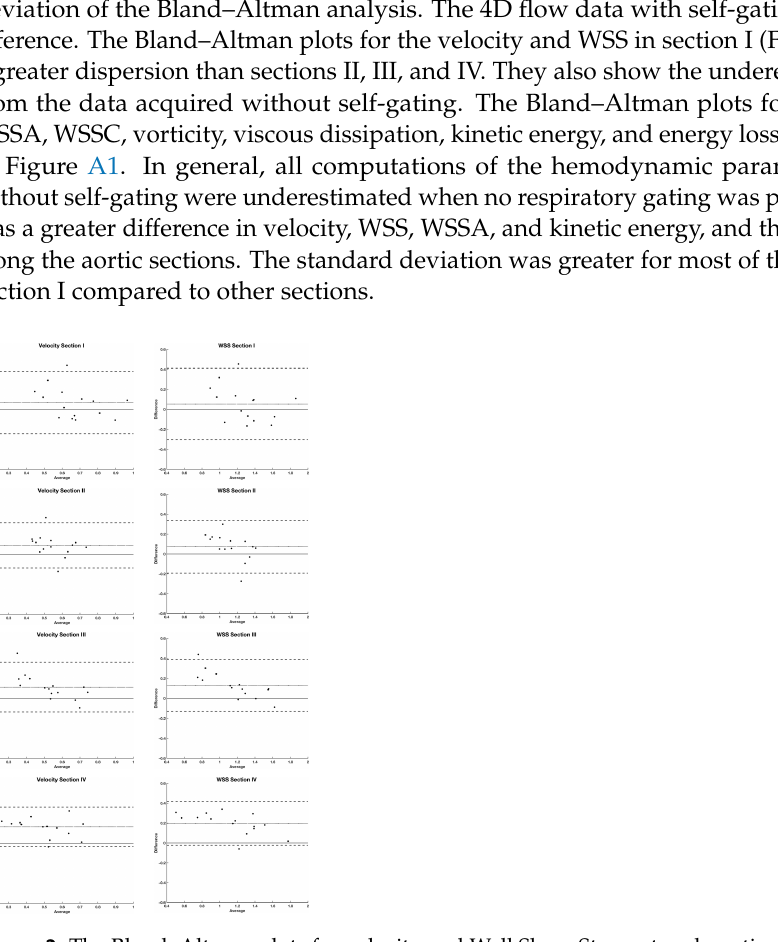
Figure 2. The Bland–Altman plots for velocity and Wall Shear Stress at each section. The difference in Bland–Altman plots was computed as 𝑆𝐺−𝑁𝐺 , where SG is the data with self-gating and NG is the data without self-gating. Appendix A shows the Bland–Altman plots of all hemodynamic pa- rameters considered in this work. Finally, the mean and range of the DICE coefficient between the segmentation of the self-gated and non-gated data were 0.918 ± 0.056. This result, which considered the whole segmented aorta, showed a high intersection between both segmentations. A graphical analysis of the local differences [22] between the meshes that were gen- erated from both segmentations shows that the disagreements between them are located